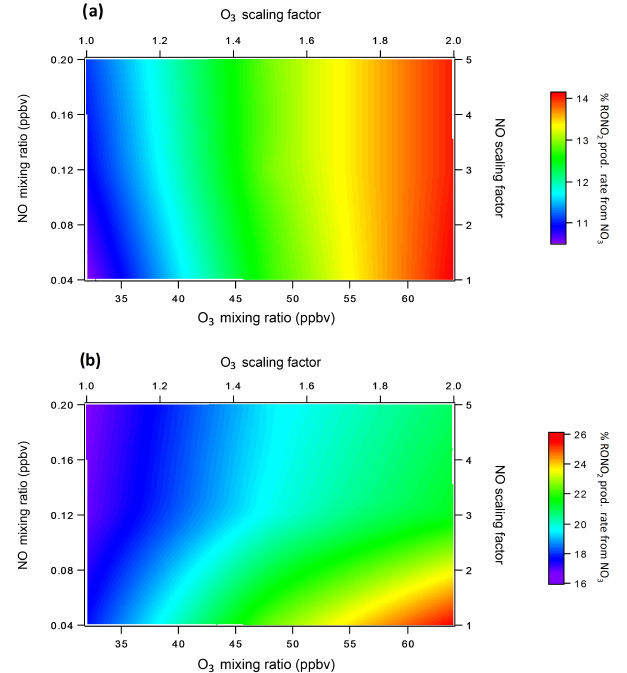
Figure 8. Percent of total daytime gas-phase RONO 2 production due to NO 3 oxidation for varying levels of O 3 and NO (a) above the canopy and (b) below the canopy. Values represent averages from 11:00 to